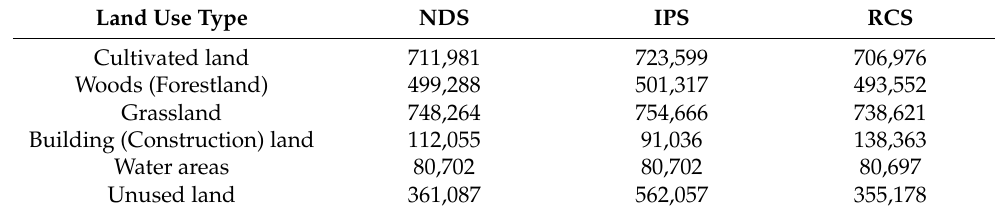
Table 3. Changes in the areas of different land types under NDS, IPS, and RCS (Unit: hm 2 ). Land Use